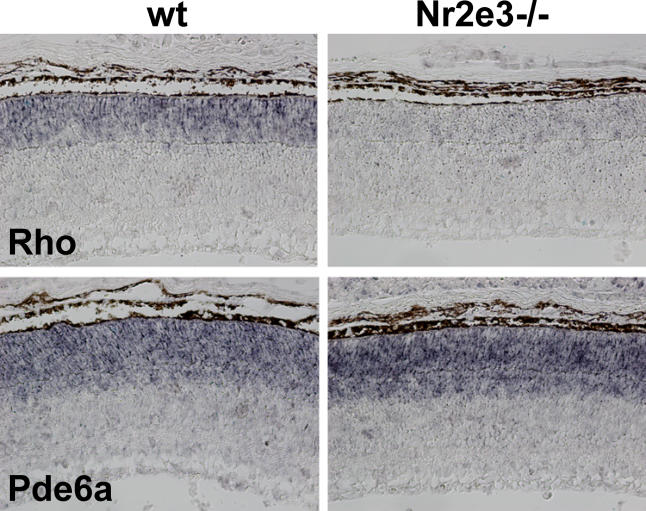
The Onset of rhodopsin Expression Is Delayed in the rd7 Mutant RetinaNote the nearly undetectable staining for rhodopsin in this P6 mutant retina (top right). The majority of rod-specific genes did not show this delay in expression onset, as indicated by the normal amount of staining for Pde6a in the mutant at P6 (bottom images).